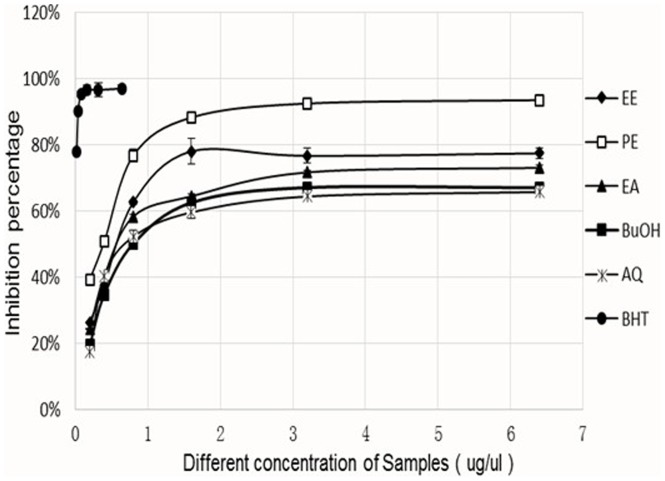
Deoxyribose scavenging activity of the GL extracts.